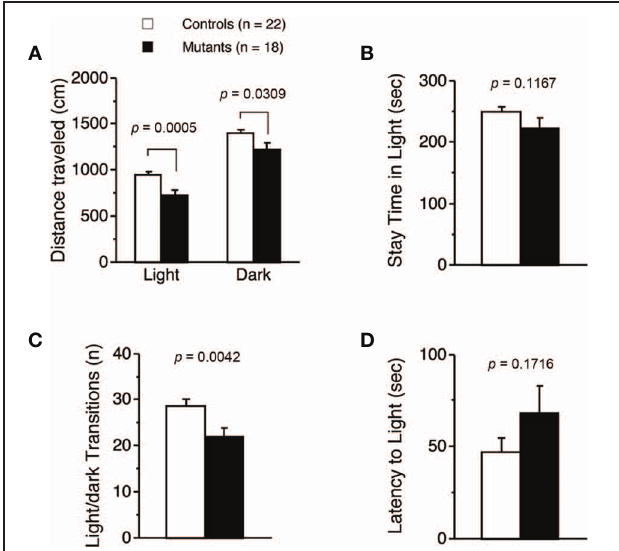
FIGURE 1 | Decreased locomotor activity of Apc + / − mice 7–9 weeks of age. (A) Distance traveled of Apc + / − mice (Mutants) was significantly decreased compared to wild-type mice (Controls) in light and dark. (B) No significant difference in time spent in light between genotypes was detected. (C) The number of transitions between the light and dark sides of Apc + / − mice was significantly decreased. (D) No significant difference in latency to light between genotypes was observed. Apc + / − mice, n = 18; wild-type mice, n = 22.